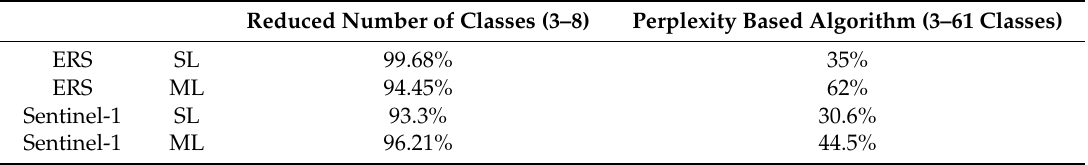
Table 4. Percentage of identified Persistent Scatterers classified in the same category of